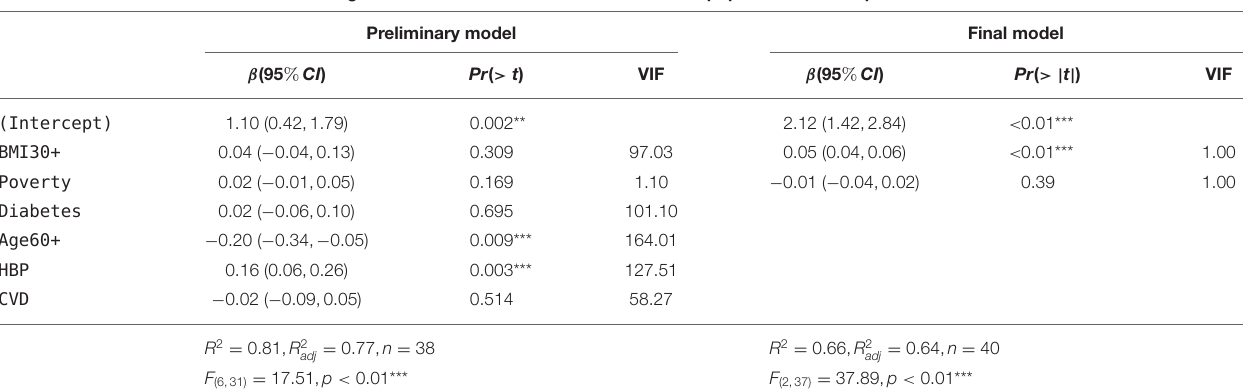
TABLE 7 | Linear models with infection and mortality rates as response variables for NHB. Linear regression models with infection rate in NHB population as a response